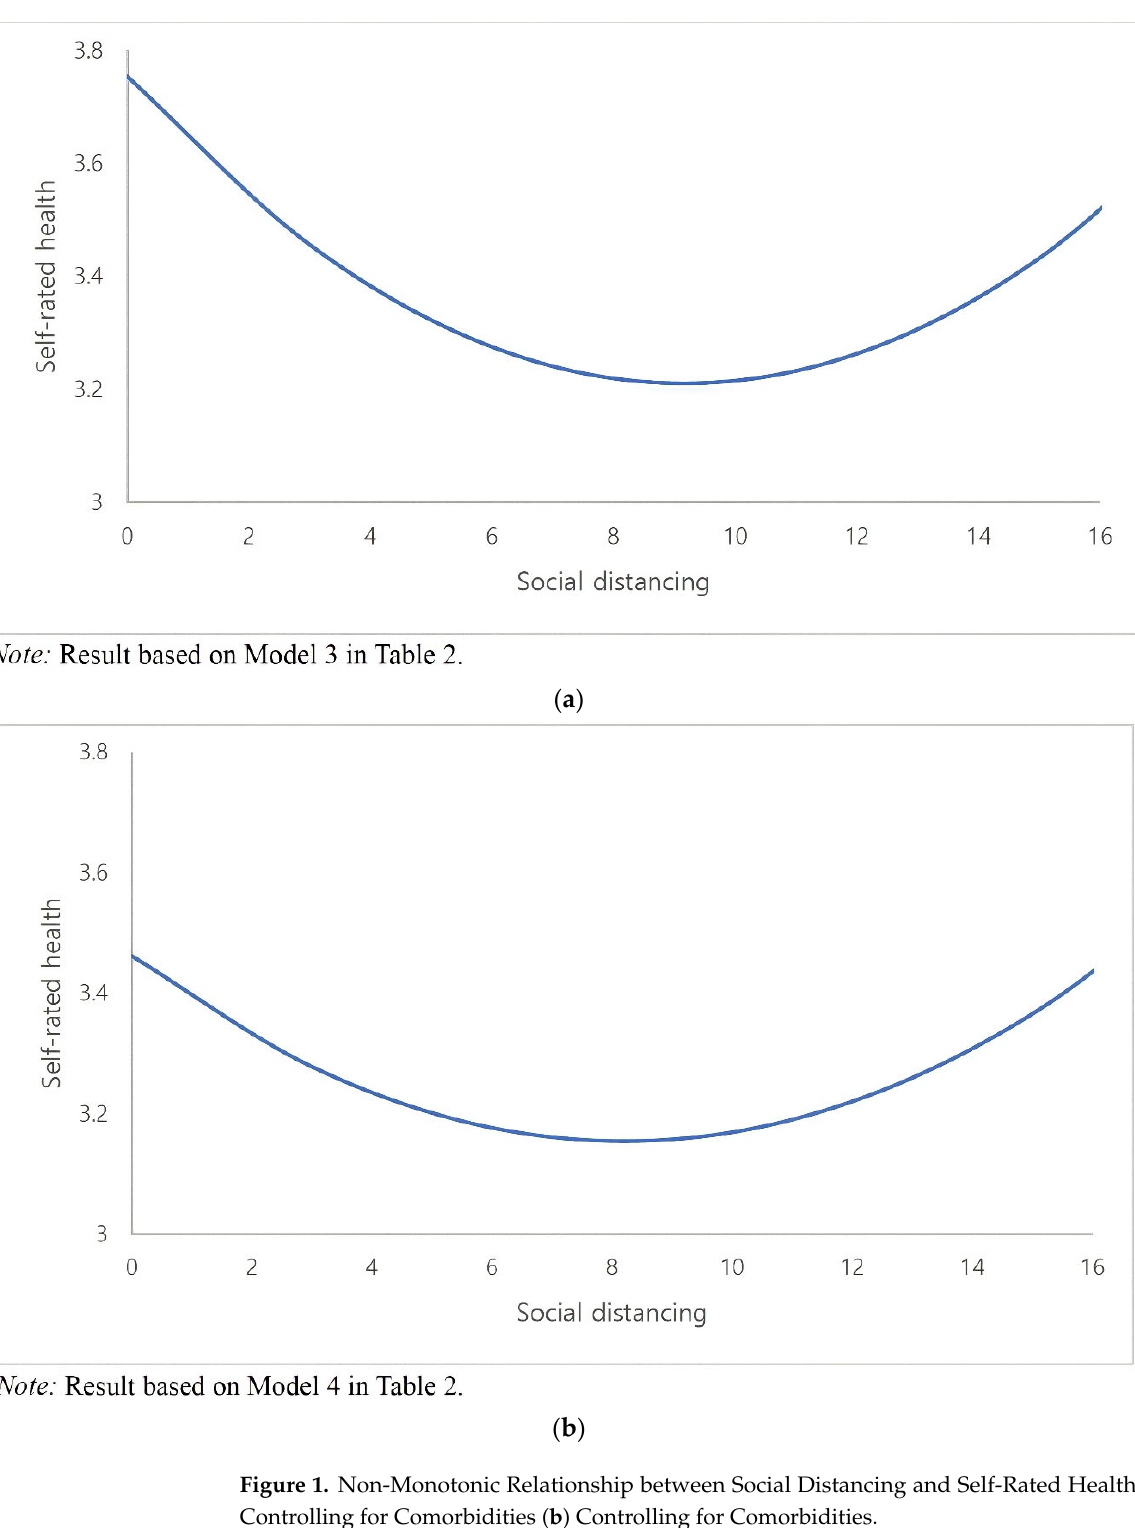
Figure 1. Non ‐ Monotonic Relationship between Social Distancing and Self ‐ Rated Health: ( a ) Not Figure 1. Non-Monotonic Relationship between Social Distancing and Self-Rated Health: ( a ) Not Controlling for Comorbidities ( b ) Controlling for Comorbidities. Controlling for Comorbidities ( b ) Controlling for